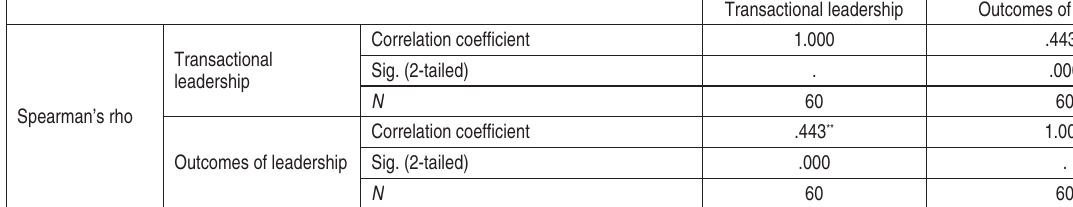
Transactional leadership